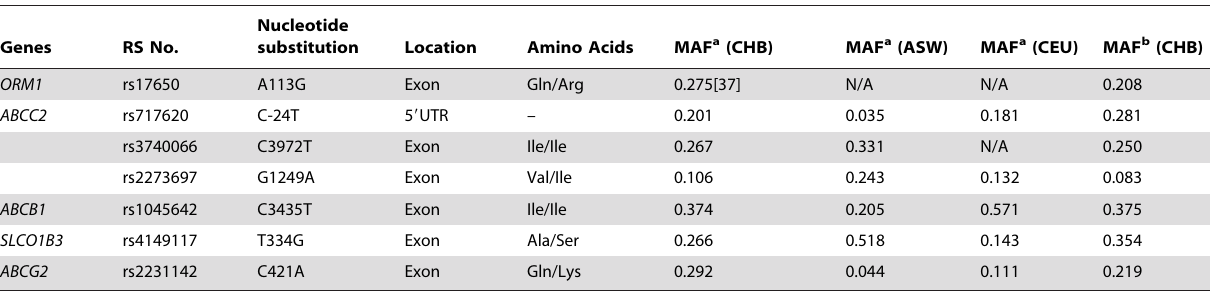
Table 2. Summary of Genetic Variations of SNPs in this Study.